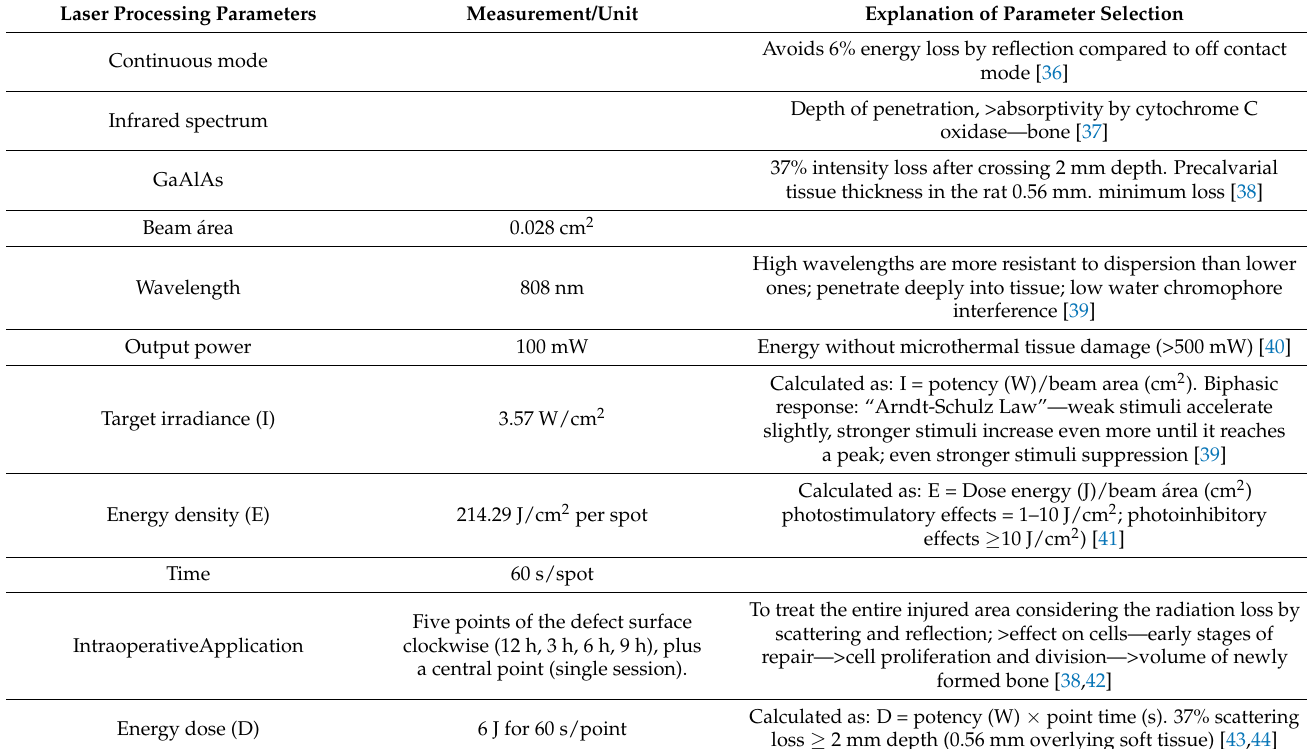
Table 1. Selection of laser processing parameters that allow their correlation with desired